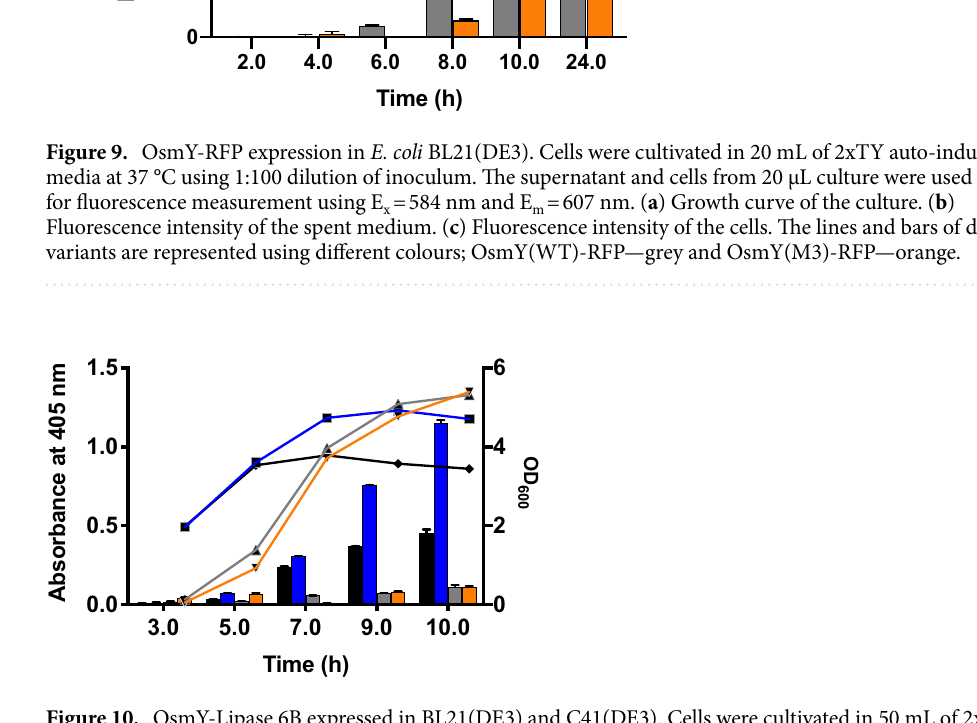
Figure 10. OsmY-Lipase 6B expressed in BL21(DE3) and C41(DE3). Cells were cultivated in 50 mL of 2xTY auto-induction media at 37 °C using 1:100 dilution of inoculum. The cell optical densities monitored at 600 nm are shown as lines. The activity of OsmY-Lipase6B in the spent medium measured with the pNPA assay using an absorbance at 405 nm are shown as bars. The lines and bars of different samples are represented using different colours; OsmY(WT)-Lipase 6B in C41(DE3)—black, OsmY(M3)-Lipase 6B in C41(DE3)—blue, OsmY(WT)- Lipase 6B in BL21(DE3)—grey and OsmY(M3)-Lipase 6B in